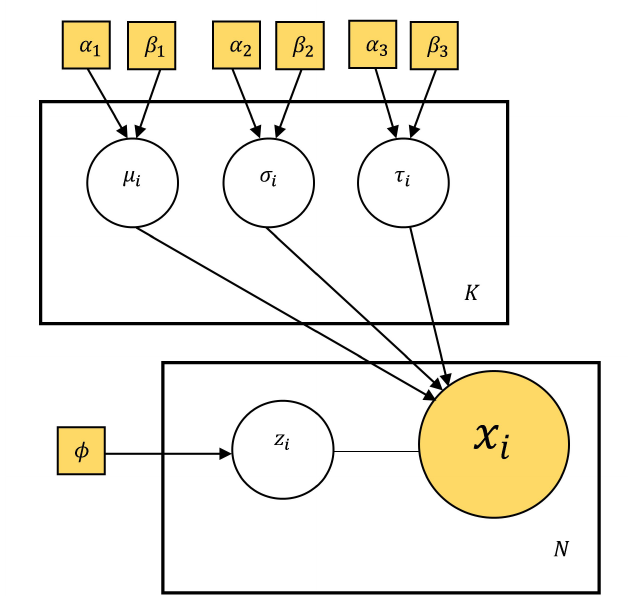
Figure 3. Bayesian Mixture Ex-Gaussian SSRT model using plate notation. Filled in shapes indicate known